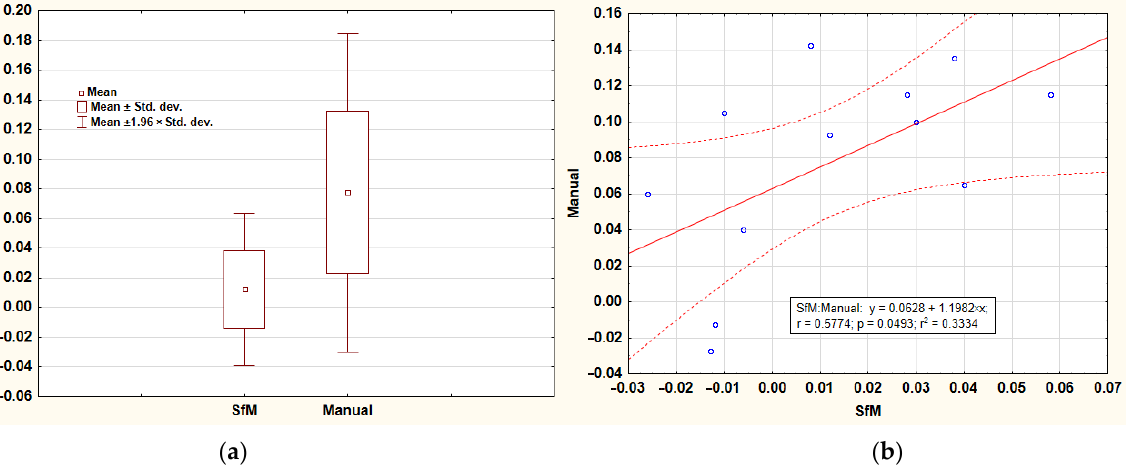
Figure 9. Average volume changes (m 3 ) calculated by SfM method and from manual measurements ( a ) and the regression and correlation analysis between volume changes (m 3 ) after individual passes (blue circles) calculated from SfM vs. manual method ( b ). The dashed lines in the right picture represent 95% confidence interval.